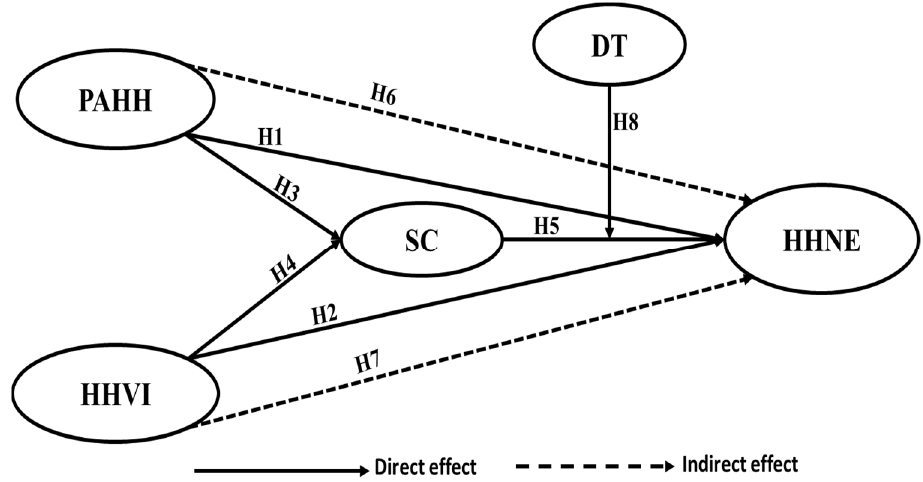
Figure 1. The proposed conceptual framework and hypotheses. PAHH → Perceived Authenticity of Heritage Hotels; HHVI → Heritage Hotel Visitor Involvement; SC → Self-Congruity; DT → Digital Technology; HHNE → Heritage Hotel Nostalgia Experience.